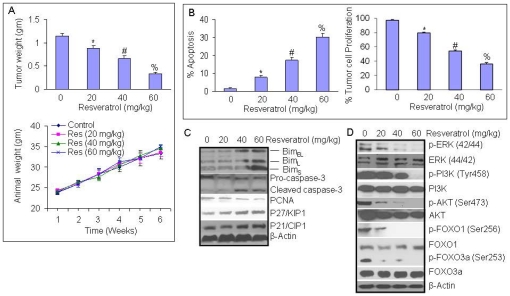
Resveratrol inhibits the growth of PANC-1 tumors orthotopically inplanted in Balb C Nude mice by inhibiting FOXO transcription factors.(A) Upper Panel, PANC-1 cells were orthotopically implanted into the pancreas of Balb C nude mice. Tumor bearing mice were treated with resveratrol (0–60 mg/kg body weight) through gavage (Monday to Friday, once daily) for 6 weeks. At the end of the experiment, pancreatic tumor weights were recorded. Data represent the mean ± S.D. *, #, % = significantly different from control, P<0.05. Lower Panel, Body weight of tumor-bearing mice during the experiment. Data represent the mean ± S.D. (B), Effects of resveratrol on apoptosis and cell proliferation in tumor tissues. Immunohistochemistry was performed in tumor tissues isolated from control and resveratrol treated mice. Apoptosis was measured by TUNEL assay and cell proliferation was measured by Ki67 staining. Data represent the mean ± S.D. *, #, % = significantly different from control, P<0.05. (C), Effects of resveratrol on markers of apoptosis and cell cycle in tumor tissues. Western blot analyses were performed to examine the expression of Bim, caspase-3, PCNA, cell cycle inhibitors p27 and p21. The β-actin was used as a loading control. (D), Effects of resveratrol on ERK, PI3K/AKT and FOXO proteins isolated from tumor tissues. Western blot analyses were performed to examine the expression of p-ERK, ERK, p-PI3K (Tyr458), PI3K, p-AKT (Ser473), AKT, p-FOXO (Ser256), FOXO, p-FOXO3a (Ser253), and FOXO3a. The β-actin was used as a loading control.